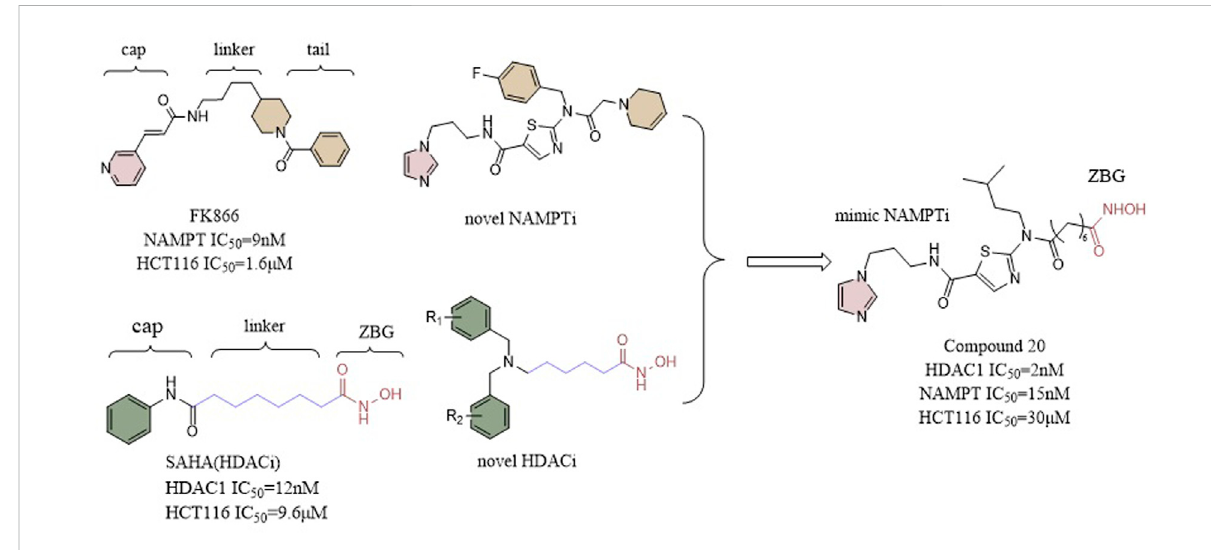
FIGURE 11 Structure design of HDAC and NAMPT dual inhibitors in Chen ’ s